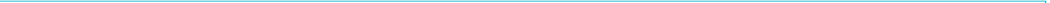
Figure 1: Influence of angiotensin-converting enzyme inhibitors (ACEIs) or angiotensin-II receptor blockers (ARBs) used as hyper- tension medication on acid-base balance regulation. Blocking the renin-angiotensin-aldosterone system with ACEIs or ARBs reduces re- nal acid elimination, leading to constant activation of brainstem-mediated chemoreceptor reflex to increase acid elimination by ventilation and burdens cardiopulmonary system. (Figure modified from Liao et al.